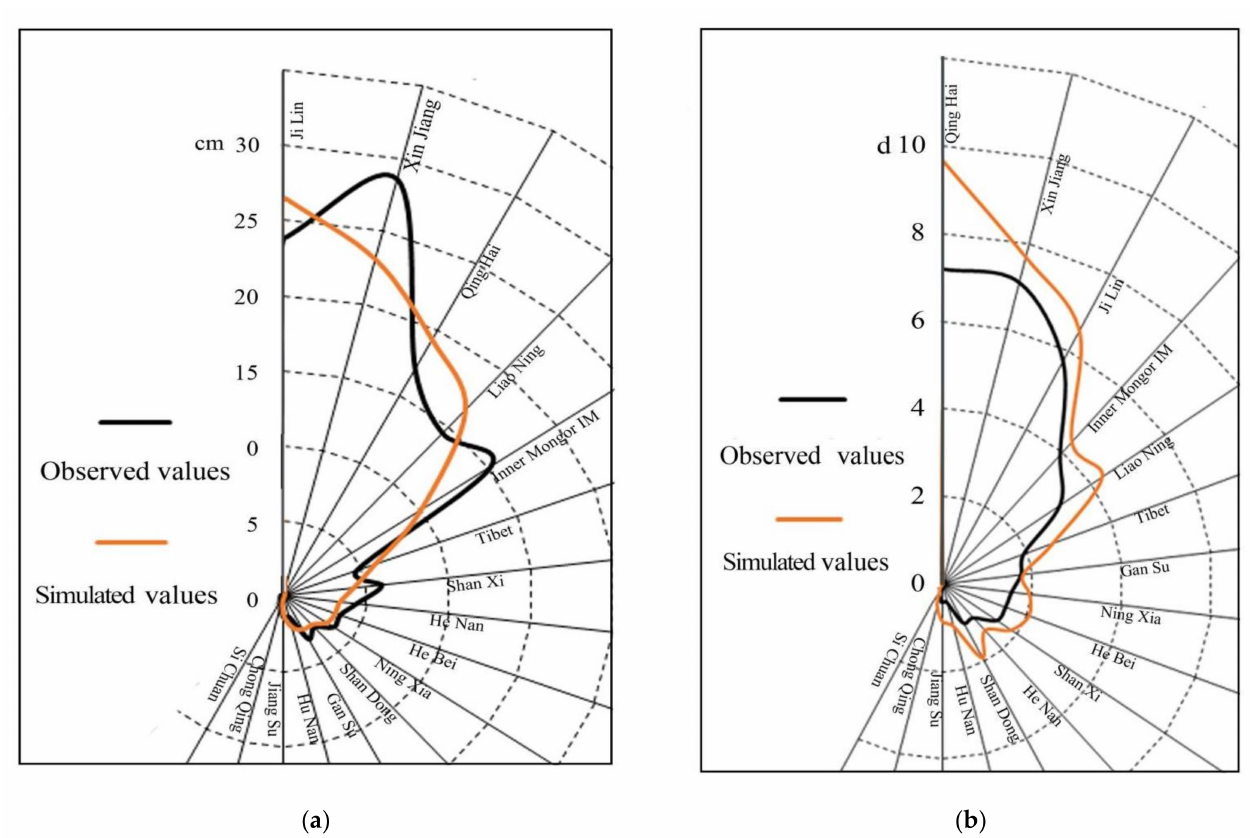
Figure 9. Observed and iterative simulated values at the provincial scale for: ( a ) cumulative snow depth, and ( b ) cumulative snow cover days.